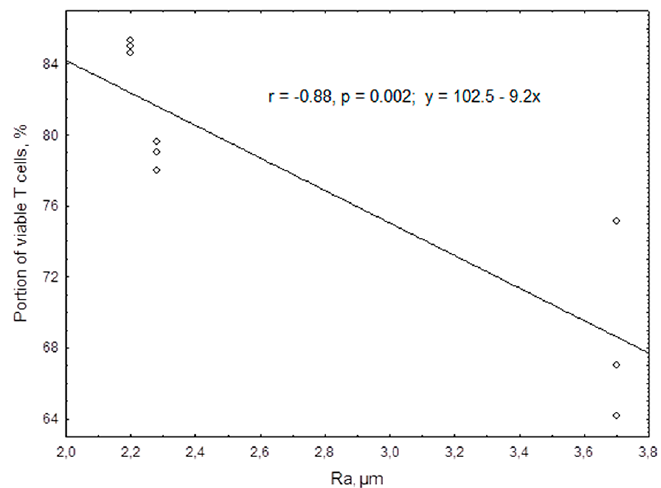
Figure 4. Regression of Jurkat T cell viability after 24 h of culture in the presence of rough TiO 2 -coated titanium samples.